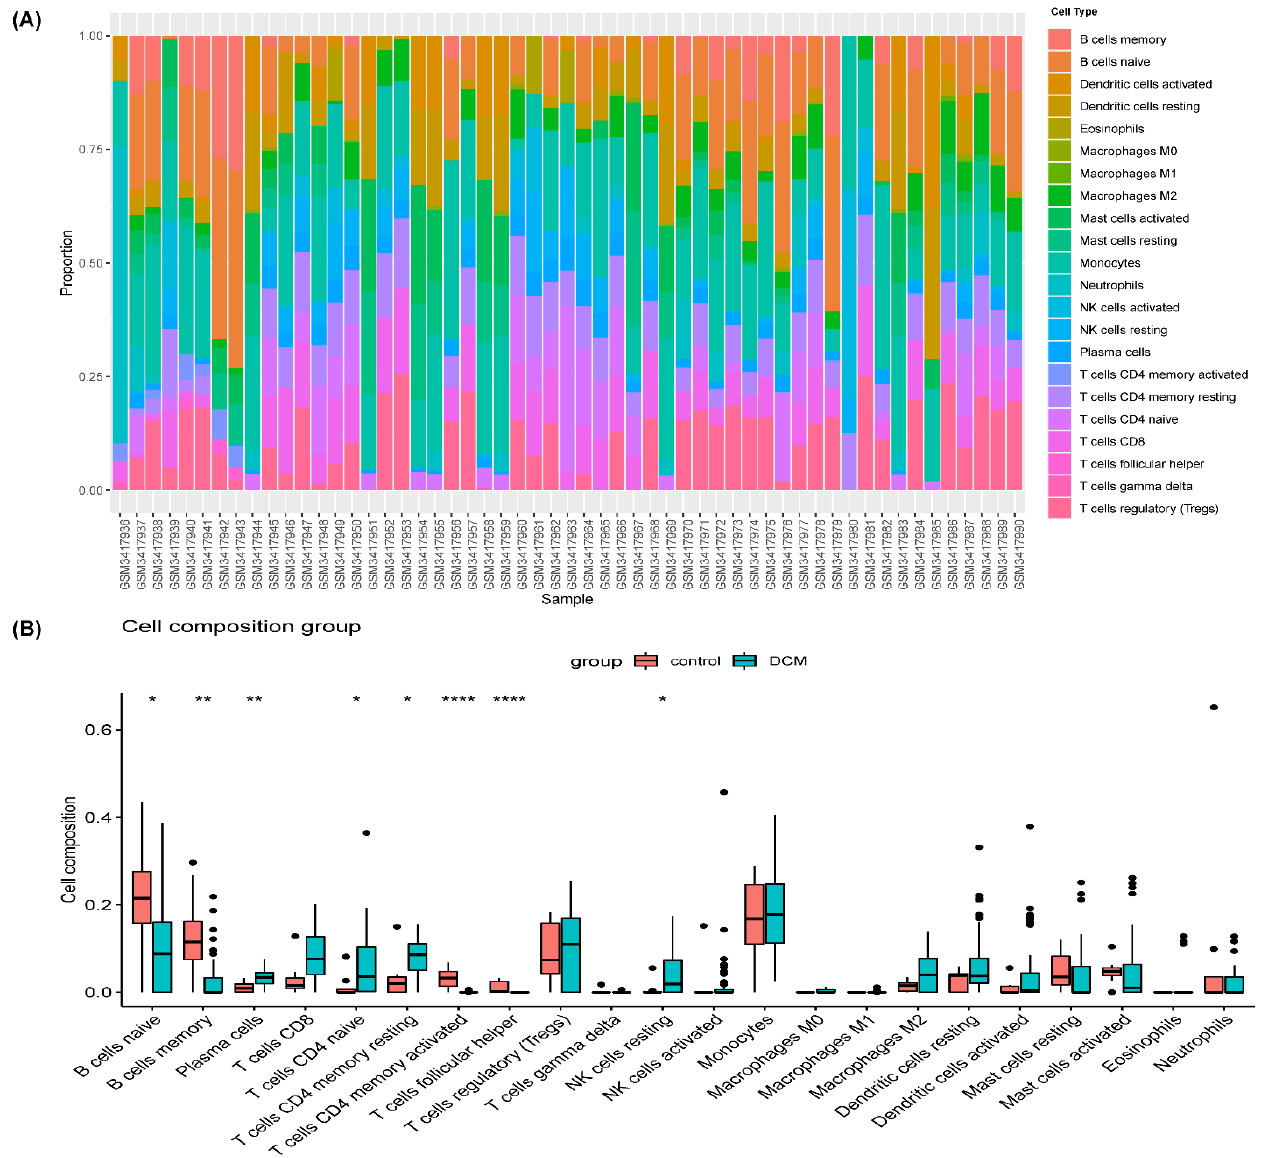
Figure 4. Immune infiltration analysis for GSE120895. ( A ) Bar charts of 22 immune cell proportions in DCM and control tissues. ( B ) Differential expression of immune cells in two groups. * p < 0.05, ** p < 0.01, **** p < 0.0001.